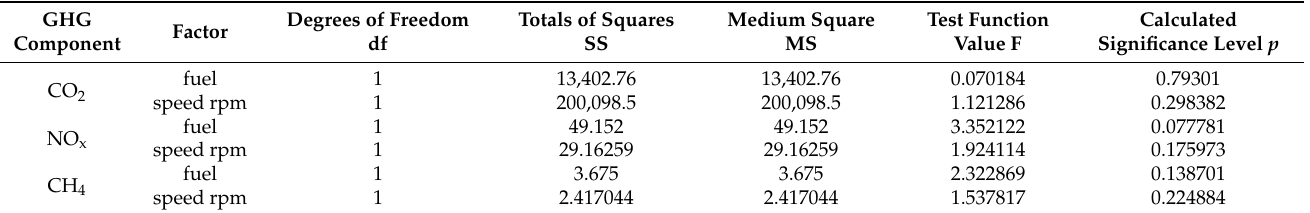
Table 10. ANOVA results for the GHG component emissions (g · kWh − 1 ) due to fuel and engine speed (biodiesel,